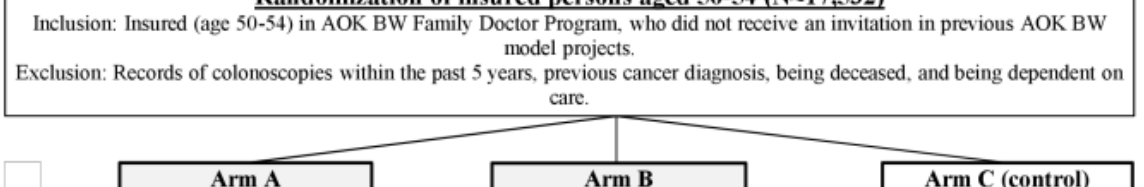
Figure 1. Study design. Total expected fecal immunochemical test (FIT) use per study arm: A=35%, B=17.5%, and C=10%. Participants in arms A and B may receive a FIT as part of the intervention or can additionally request it in routine practice. Participants in arm C (ie, control) can only use the FIT in routine practice. Data on the use of screening methods until 1 year after the initial invitation will be collected. AOK BW: AOK Baden-Wuerttemberg; A1 and A2: subgroups of arm A; and B1 and B2: subgroups of arm